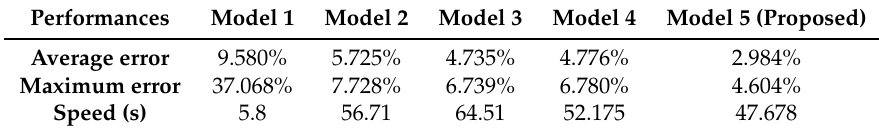
Table 10. EKF estimation error using different OCV models (pulse current load) at 25 ◦